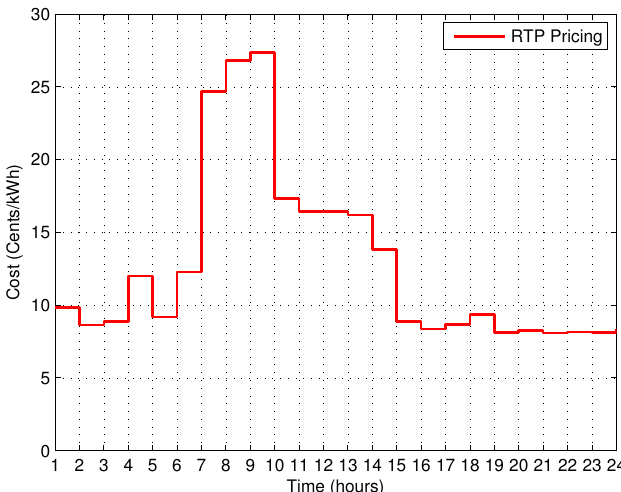
Figure 4. Real-Time Pricing (RTP) price-based Demand Response (DR) program.